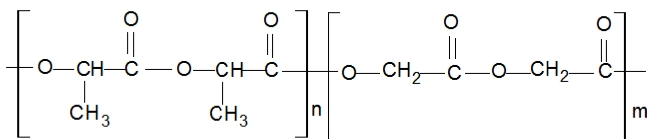
Figure1. Chemicalformulaofthepoly(lactic-co-glycolicacid)(PLGA)bioresorbablepolymerdeveloped Figure 1. Chemical formula of the poly(lactic-co-glycolic acid) (PLGA) bioresorbable polymer at the Centre of Polymer and Carbon Materials developed at the Centre of Polymer and Carbon Materials [27].